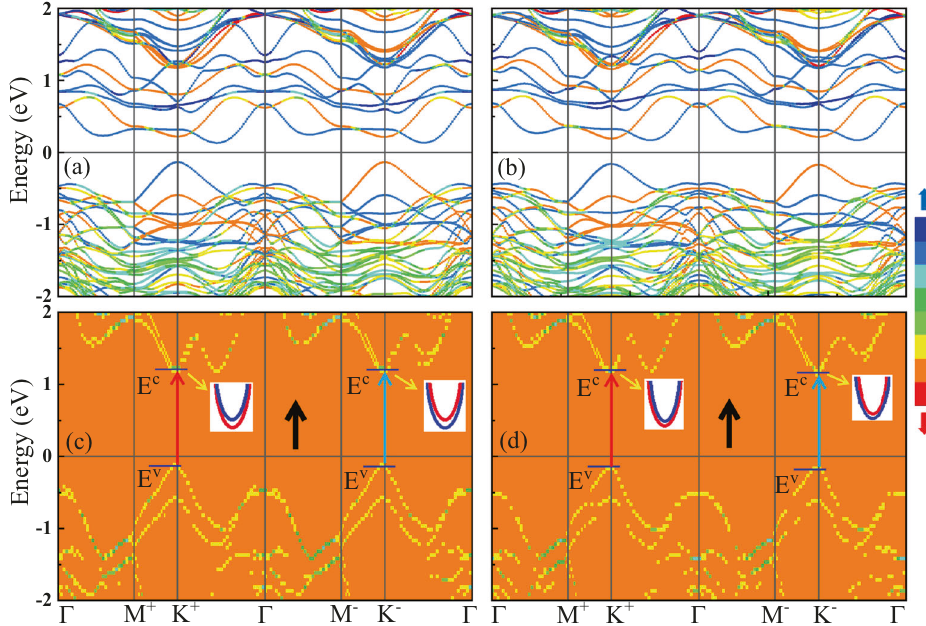
Fig. 3 Projected band structures. Calculated projected band structure including spin-orbit coupling in [001] direction of a S-1 stacking b S-2 stacking. The blue and red colors represent the spin up and down components. The unfolded band structure of projected on the WSe 2 monolayer for c S-1 stacked structure and d S-2 stacked